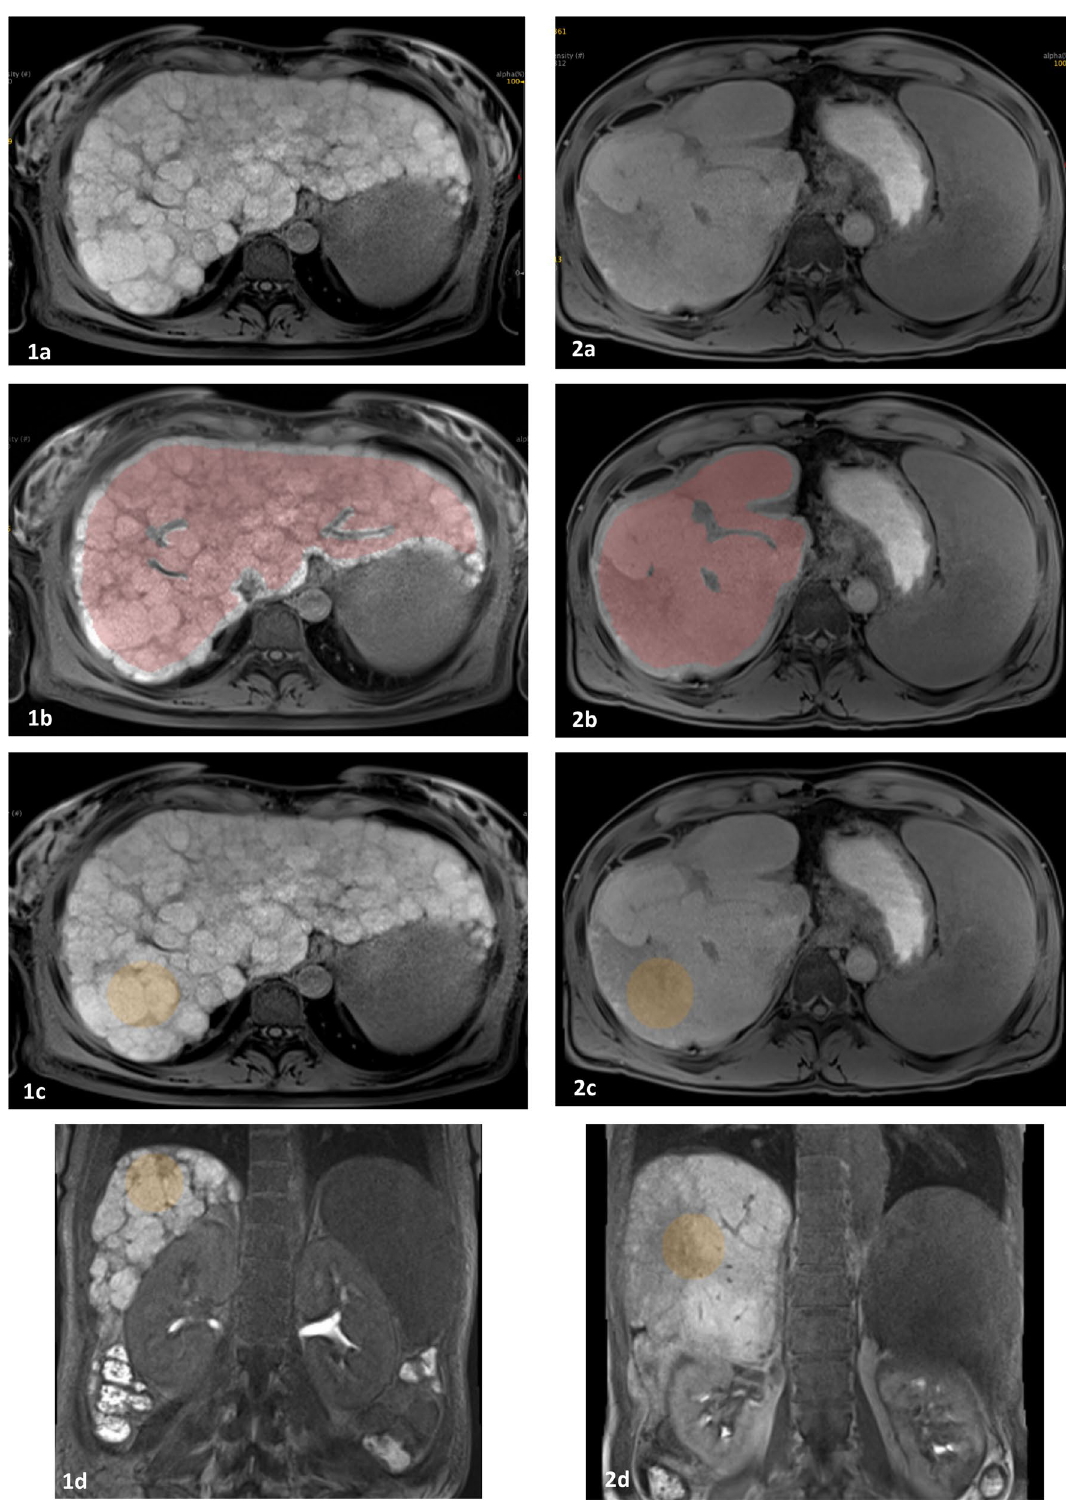
Figure 5. Gadoxetic acid-enhanced hepatobiliary phase (HBP) MR images showing region of interest (ROI) segmentation in two-dimensional (2D) and three-dimensional (3D) format. HBP images, axial before ( a ) and after ( b , c ) 2D ( b ) and 3D ( c ) ROI segmentation as well as coronal ( d ) reconstructed images showing 3D ROI segmentation. Patient 1 is a 36-year-old female with nonalcoholic steatohepatitis (NASH)-associated liver cirrhosis. Patient 2 is a 47-year-old male with primary sclerosing cholangitis complicated by liver